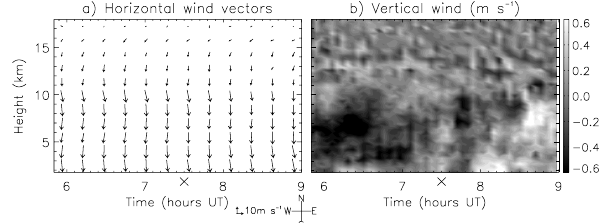
Fig. 4. Height-time plots of horizontal and vertical wind measured by VHF radar, centred on the time (marked × ) of Fig. 2. The ver- tical wind shows some mountain waves, up to a height of roughly 14km where the horizontal wind falls near zero. The radar is about 60km south-east of label 5 in Fig.